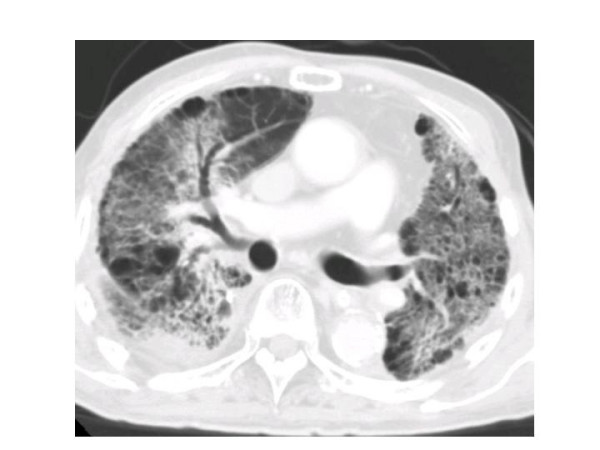
CT image of RP (patient No. 13).